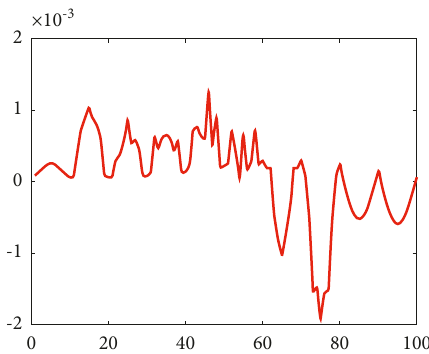
Figure 8: The error curve for the scatterer with random relative